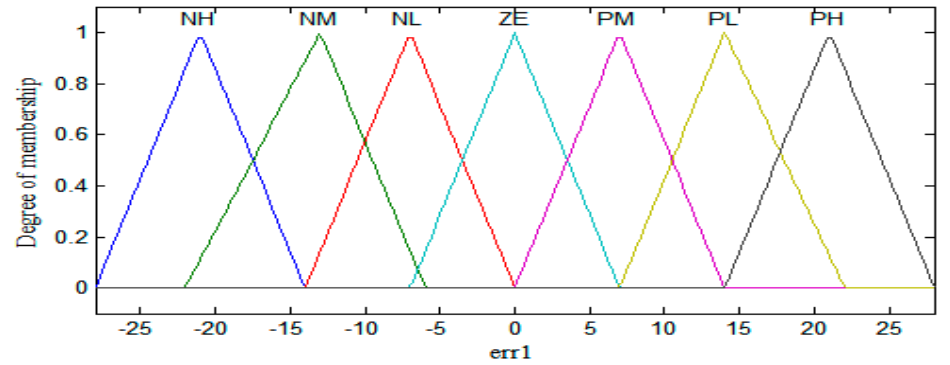
Figure 4. Temperature fuzzy controller inputs.